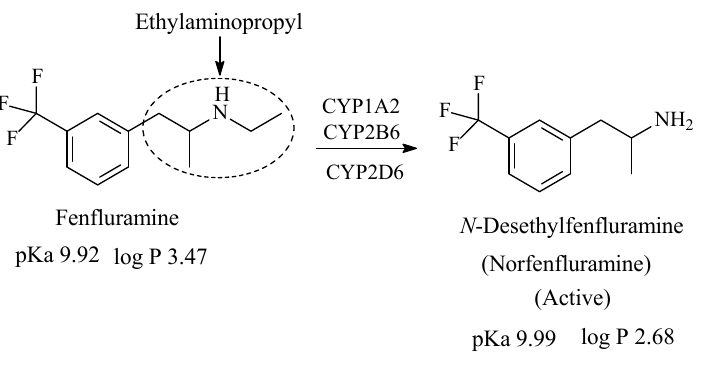
Figure 13. Metabolism of fenfluramine.